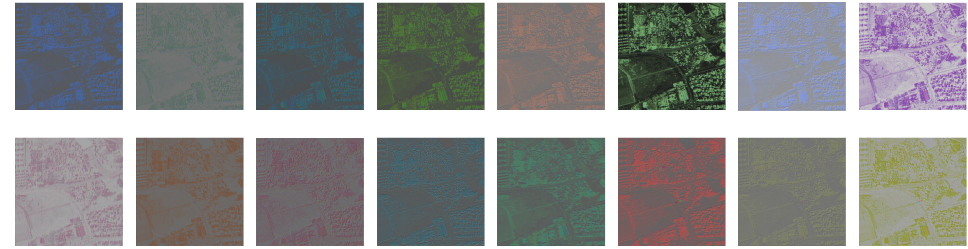
Figure 6. 16 feature maps extracted by the eighth 3D residual block of Fnet for the San-ya data.